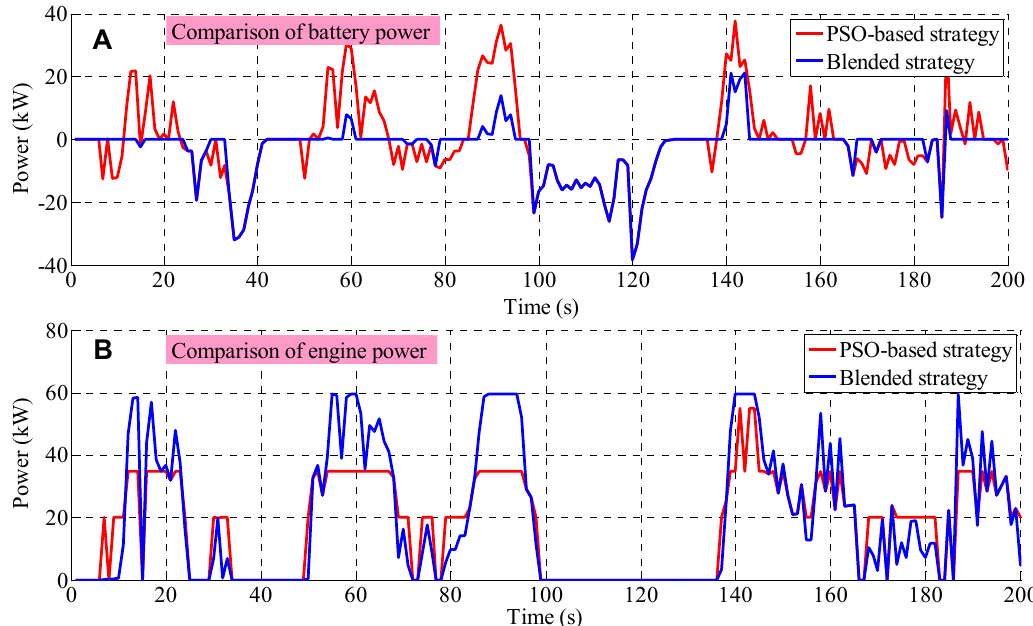
Figure 5. Simulation result of power allocation: ( A ) Battery power; ( B ) Engine output power.